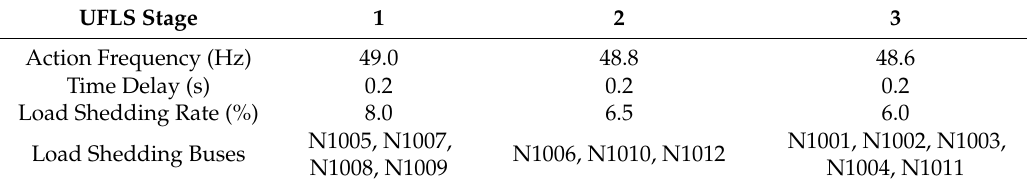
Table 1. Traditional Scheme of the